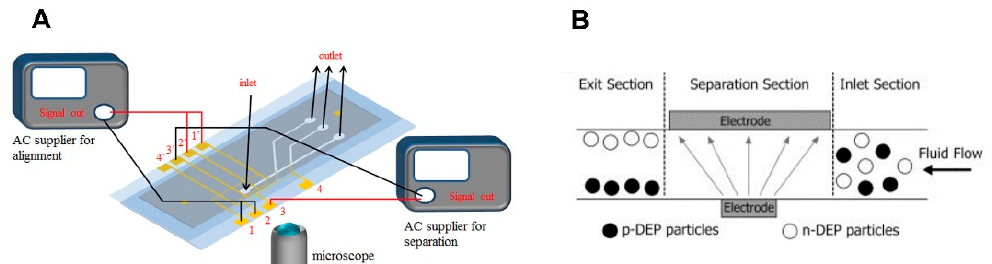
Figure 3. ( A ) Schematic of the experimental setup for separation of microalgae with different lipid contents. Reproduced with permission from [53] Y.-L. Deng et al., “Development of flow through dielectrophoresis microfluidic chips for biofuel production: Sorting and detection of microalgae with different lipid contents”, Biomicrofluidics, 2014. ( B ) Schematic drawing of DEP-based microfluidics devices: non-uniform electric field by means of asymmetric electrodes (grey arrows represent the direction of the n-DEP force). Reproduced with permission from [50] B. Çetin and D. Li, “Dielec- trophoresis in microfluidics technology”, Electrophoresis,